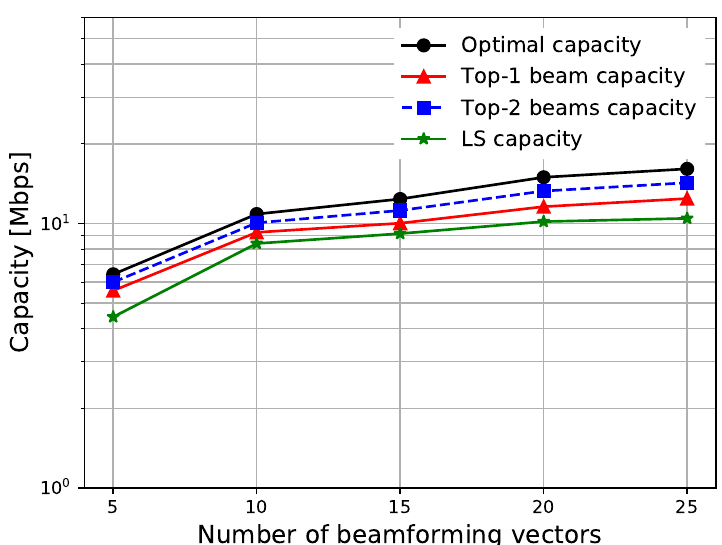
Figure 4. Achievable capacity of proposed Deep Scanning vs. number of beamforming vectors.